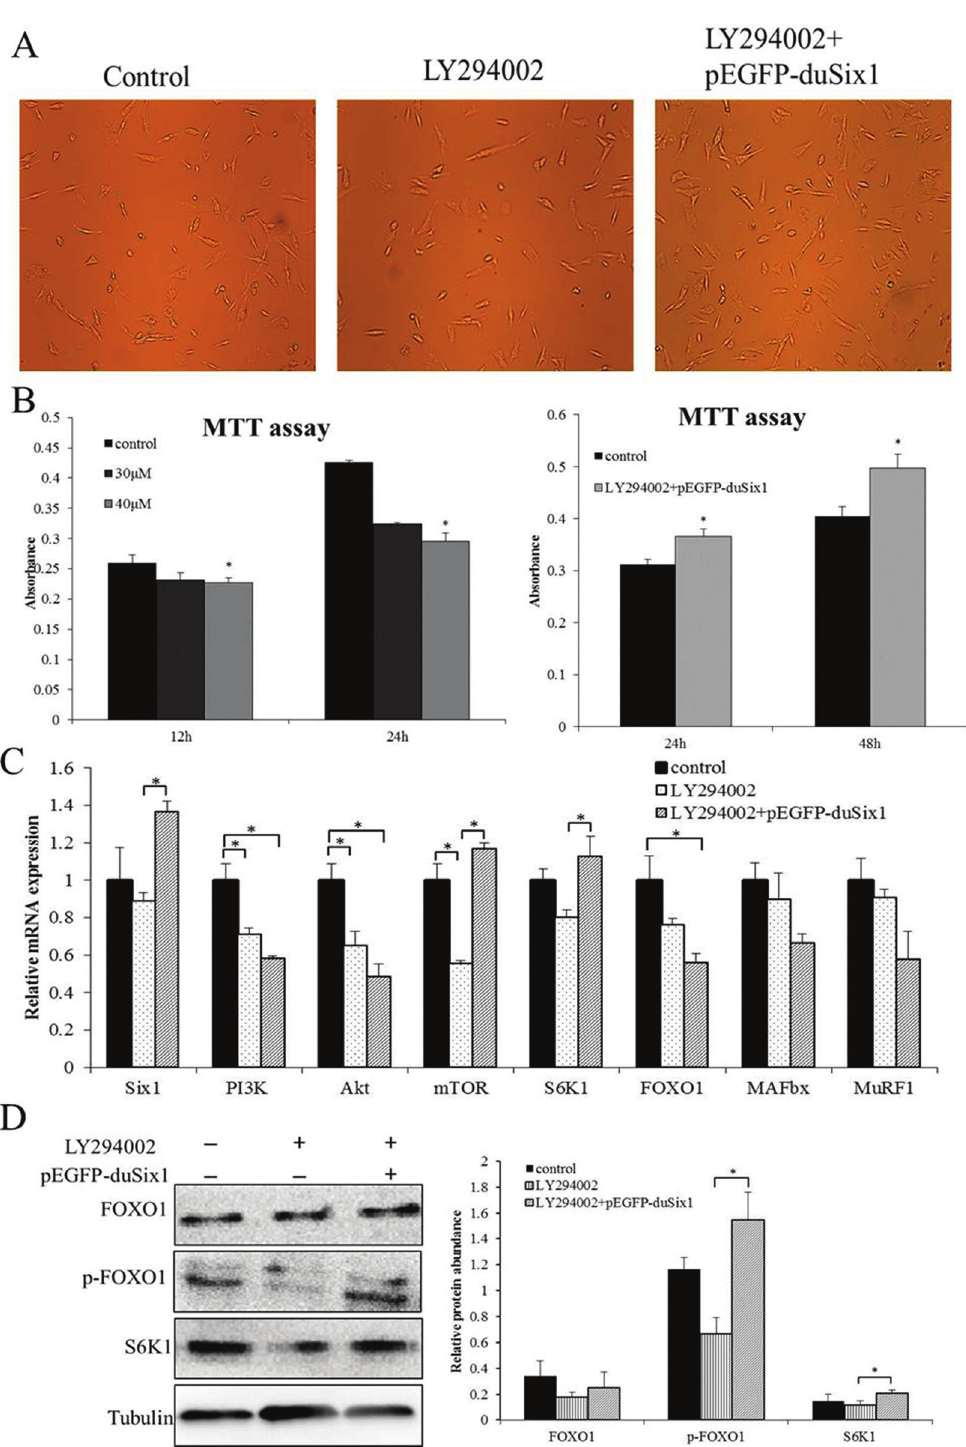
Figure 2 - Overexpression of Six1 can stimulate protein synthesis in LY294002-treated duck myoblasts. A: Representative images of myoblasts for dif- ferent treatments groups, (a) control cells, (b) LY294002 treatment cells at 24 h, (b) LY294002 treatment cells for 24 h and then transfected with pEGFP-duSix1for 48 h. B: Effects of different treatments on cell proliferation of duck myoblasts at different times. Cell proliferation was measured by MTT assay. Absorbance was measured at 570 nm, and data are presented as means (cid:6) SEM, n = 5 wells, *(P < 0.01). C: Relative expression levels of Six1 andkeygenesrelatedtoproteinsynthesisanddegradationinduckmyoblastsofdifferenttreatments.Duck (cid:2) -actinand GAPDH wereusedasinternalcon- trols. **(P < 0.01) and *(P < 0.05), values are means (cid:6) SD, n = 3 for each group. D: Western blot analysis showing the effects of transfection of Six1 on LY294002 treatments in duck myoblasts. Bar graphs showing quantification of the expression level of each protein compared with the expression of tubulin. Data are expressed as means (cid:6) SEM. Western blots are representative of three independent experiments. Western immunoblots probed with anti- bodies against FOXO1, phospho-FOXO1, S6K1 and tubulin were used as internal